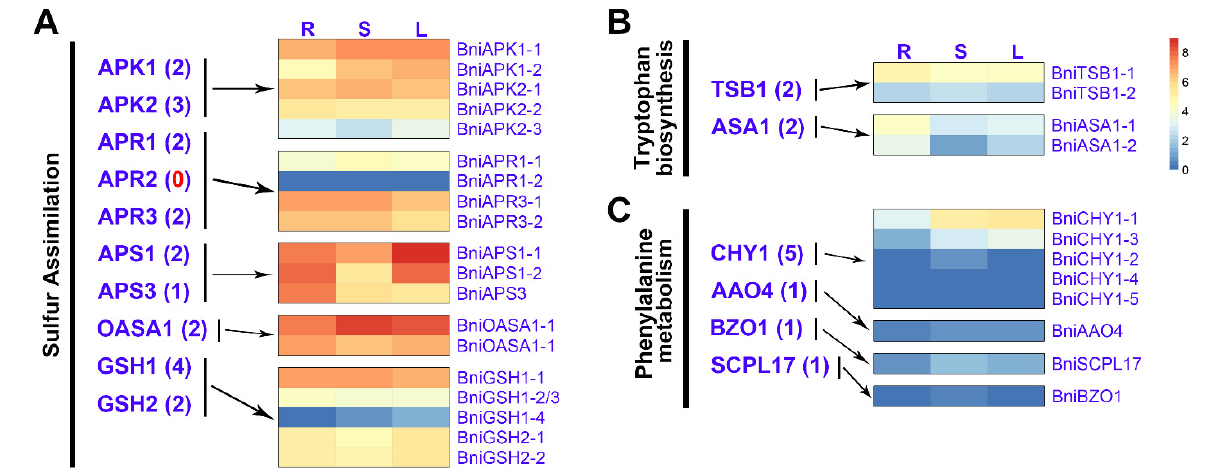
Figure 4. Heatmap of genes involved in the co-substrate pathways of GSL biosynthesis. Expression analysis of BniGSLs involved in sulfur assimilation ( A ), tryptophan biosynthesis ( B ), and phenylalanine metabolism ( C ). The number in parentheses represents the copy number of the gene. Abbreviations: AAO4, aldehyde oxidase 4; APK, adenylyl-sulfate kinase; APR, 5 ′ -adenylylsulfate reductase; APS, ATP sulfurylase; BZO1, benzoyloxy GSL 1; ASA1, anthranilate synthase α subunit 1; CHY1, 3-hydroxyisobutyryl-CoA hydrolase 1; GSH1, glutamate − cysteine ligase; GSH2, glutathione synthetase; L, leaf; R, root; S, stem; SCPL17, serine carboxypeptidase-like 17; TSB1, tryptophan synthase β chain 1.